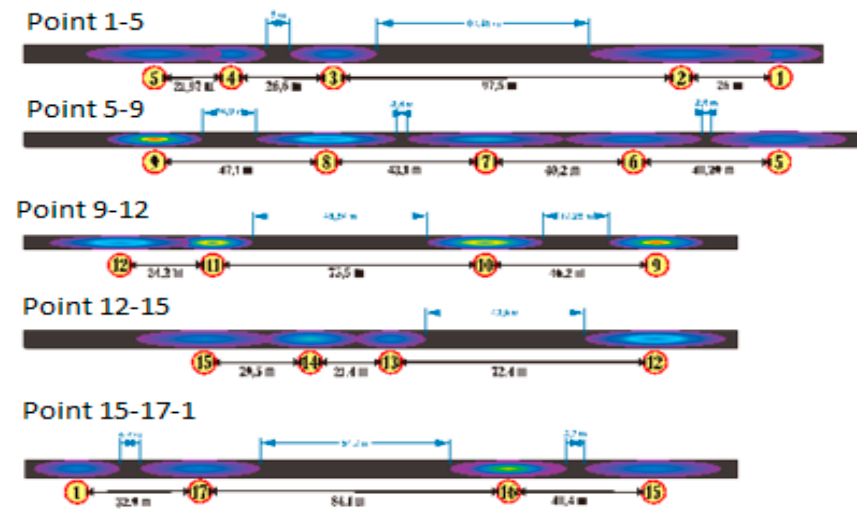
Figure 6. Evaluation results of the existing system.